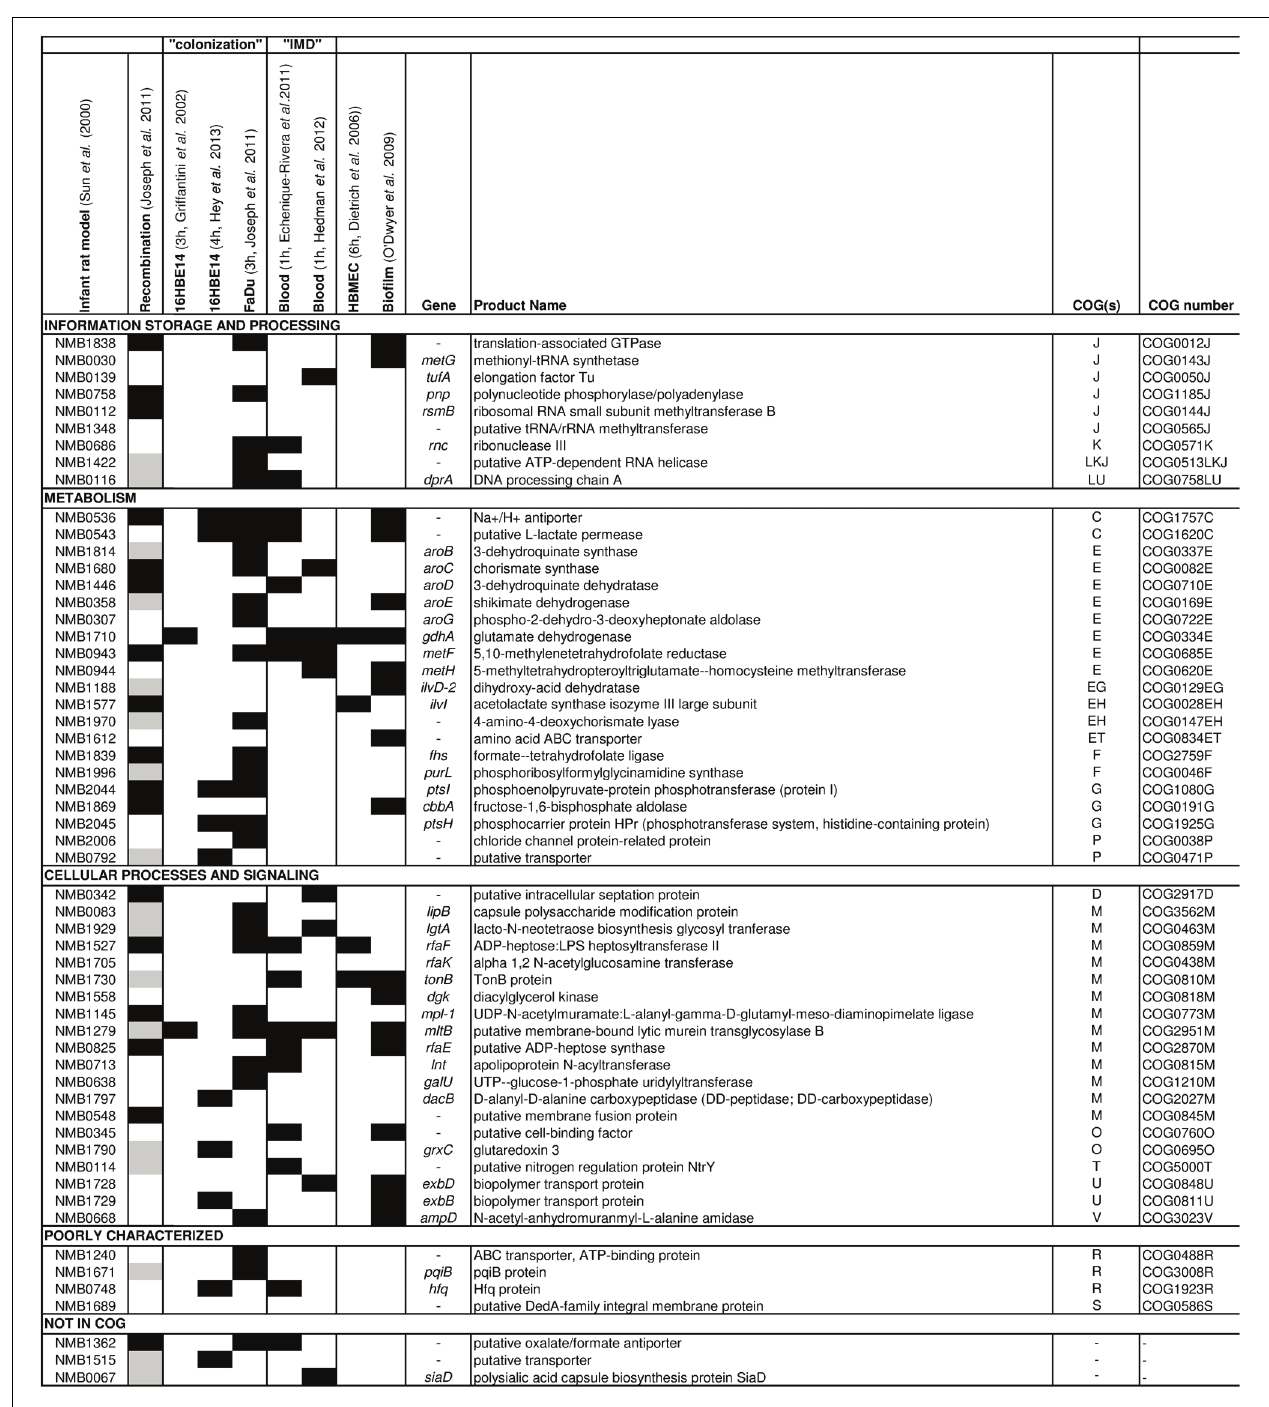
FIGURE 1 | Results from omic approaches for genes found to be essential for bacteremic disease in an infant rat model. Based on the gene set identified to be essential for bacteremic disease in an infant rat model by Sun et al. (2000) (first column), for each gene the results are depicted (from left to right) for detection of intragenic recombination (Joseph et al., 2011), expression changes in strain MC58 upon adhesion to 16HBE14 human respiratory epithelial cells after 3h (Grifantini et al., 2002b) and 4h (Hey et al., 2013), to FaDu nasopharyngeal cells after 3h (Joseph et al., 2010),